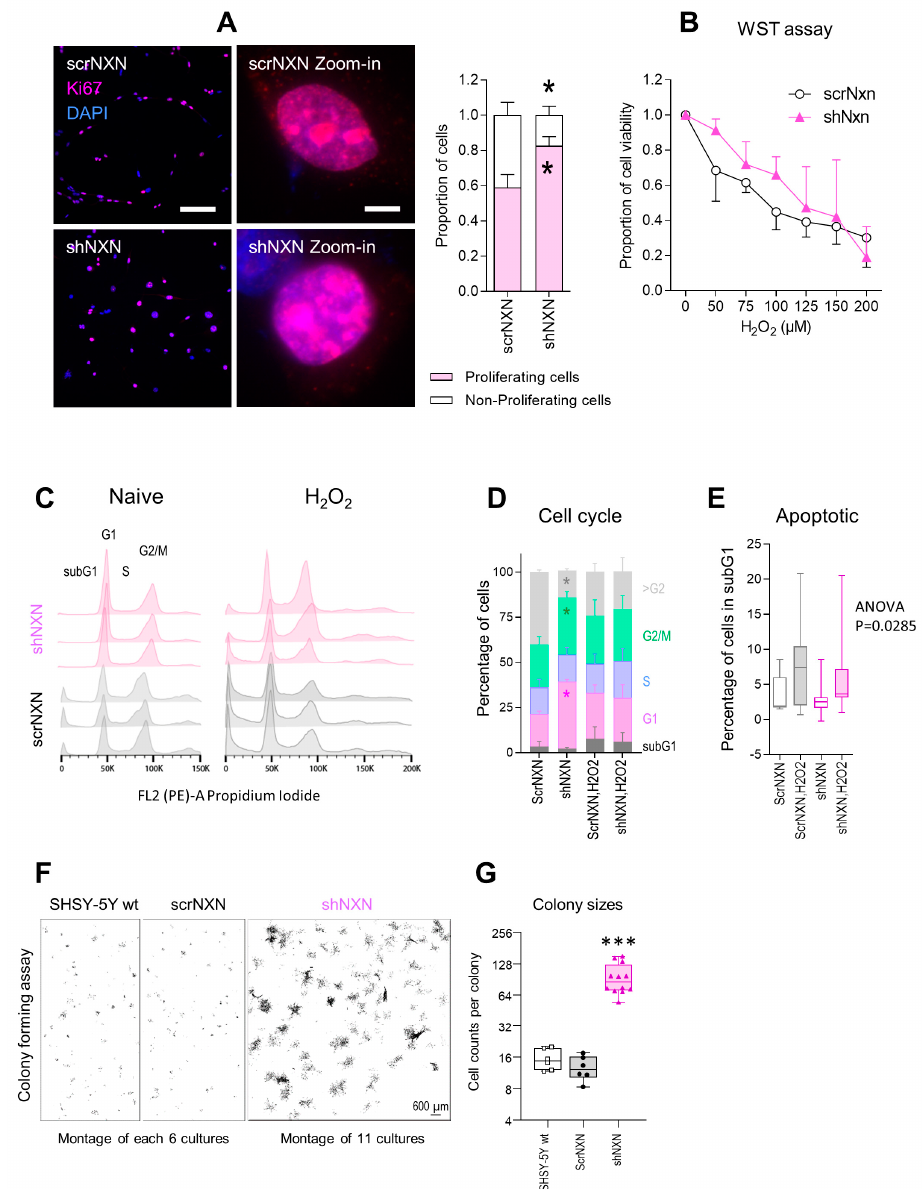
Figure 2. Proliferation and cell cycle analysis of shNXN knockdown SH-SY5Y cells. ( A ) Exemplary immunofluorescence images of the proliferation marker Ki67 and its quantification. The inserts show zoom-in images of individual nuclei. Asterisks show significant differences between groups; * p < 0.05. Scale bars: 50 µ m, 5 µ m for inserts. Sample sizes n = 5–7 cultures per group. ( B ) WST assay showing the viability of scrNXN and shNXN SH-SY5Y cells after stimulation with 0–200 µ M H 2 O 2 . The WST assay measures the metabolic activity of viable cells. Sample size n = 6 per group and time point. Two-way ANOVA not significant. ( C , D ) Flow cytometry analysis of the cell cycle distributions, based on propidium iodide staining of the DNA content in vehicle and H 2 O 2 (100 µ M) stimulated cells. C shows exemplary histograms. The stacked bar charts in D show the relative frequency of cells in G1 (N2), S and G2/M (N4). Data show the means and SD of 6 independent cultures per group; 1 x exp5 cells were counted. Exemplary curve fitting according to the Watson Pragmatic algorithm are in Supplementary Figure S1. shNXN showed higher frequencies of cells in G1 and G2/M, suggesting a higher fraction of proliferating cells. ( E ) The box plots show the percentages of cells in the subG1 phase, which are considered apoptotic/dying cells. The box is the semi-interquartile range, and the line is the median. Sample size n = 6. Two-way ANOVA p = 0.0285, post hoc n.s. ( F , G ) Exemplary images and quantification of cell colonies after seeding of single cells in a colony formation assay. The images show montages of 6 or 11 cell culture images. The size of the colonies is revealed as number of cells per colony. Data were compared with one-way ANOVA and subsequent post hoc analysis according to Šid á k. *** p <